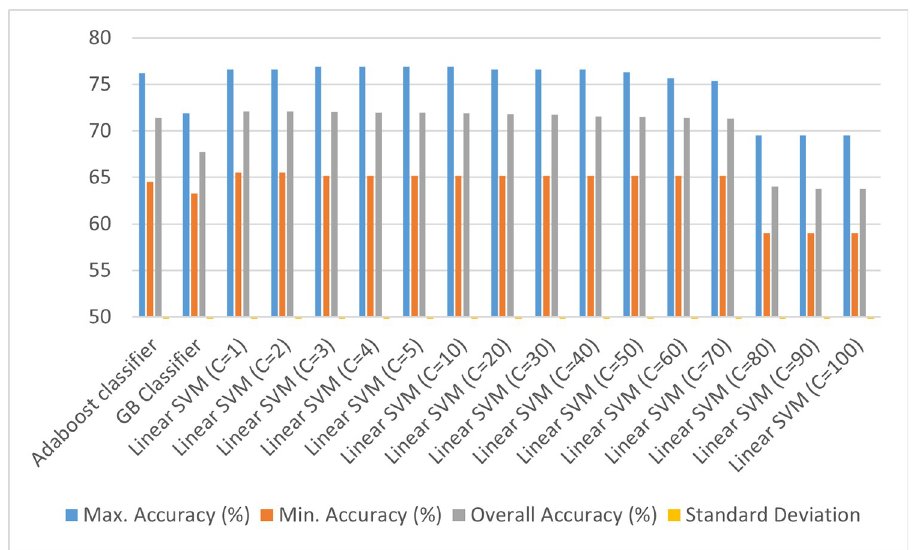
Fig 4. Classification results using power transformation on the numerical predictors and later appending the categorical predictors to the dataset.